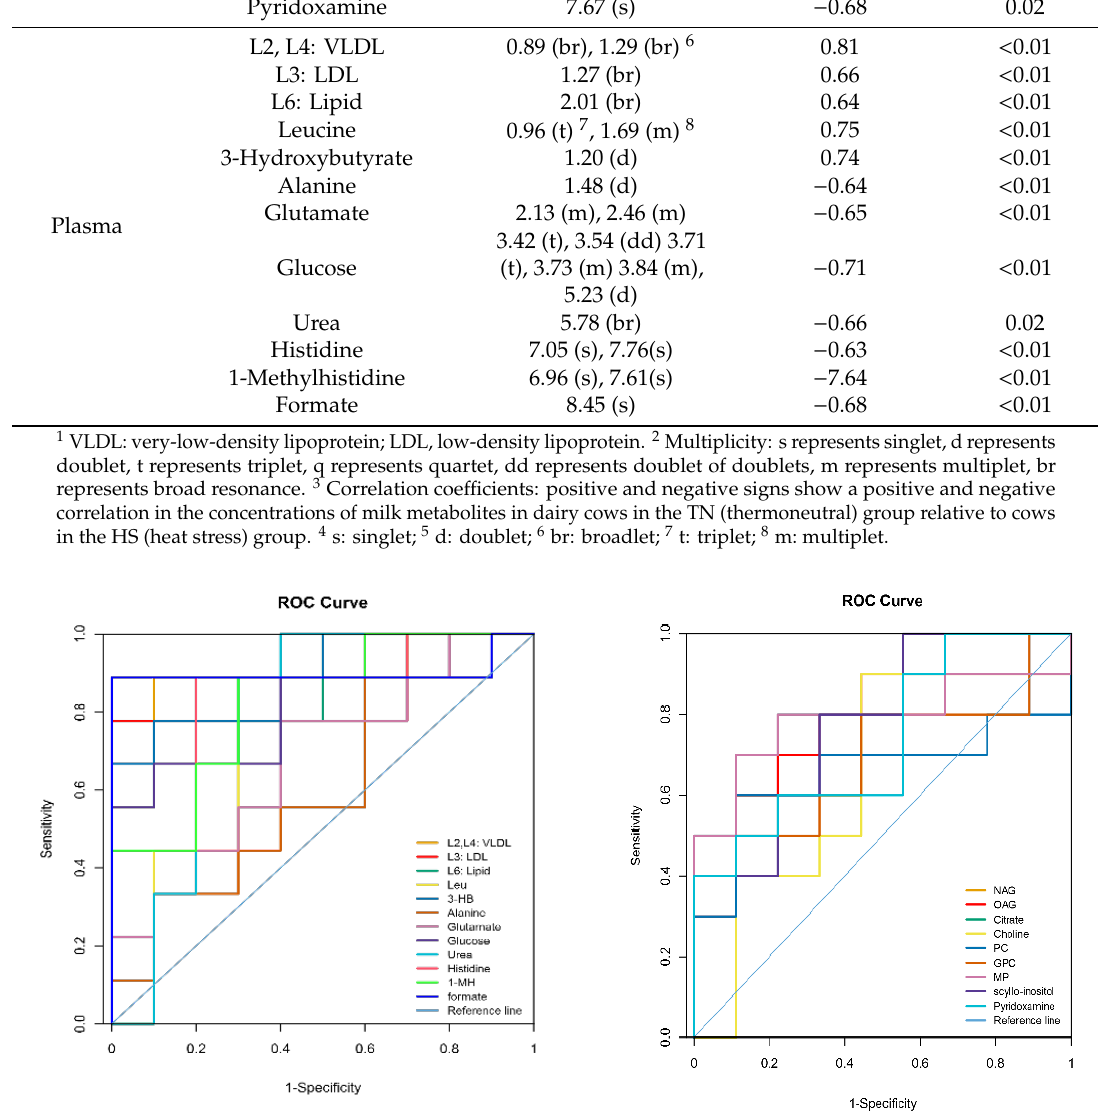
Table 4. OPLS-DA coe ffi cients derived from the 1 H NMR data of metabolites in the milk and plasma of cows reared in the heat stress and thermoneutral zone.